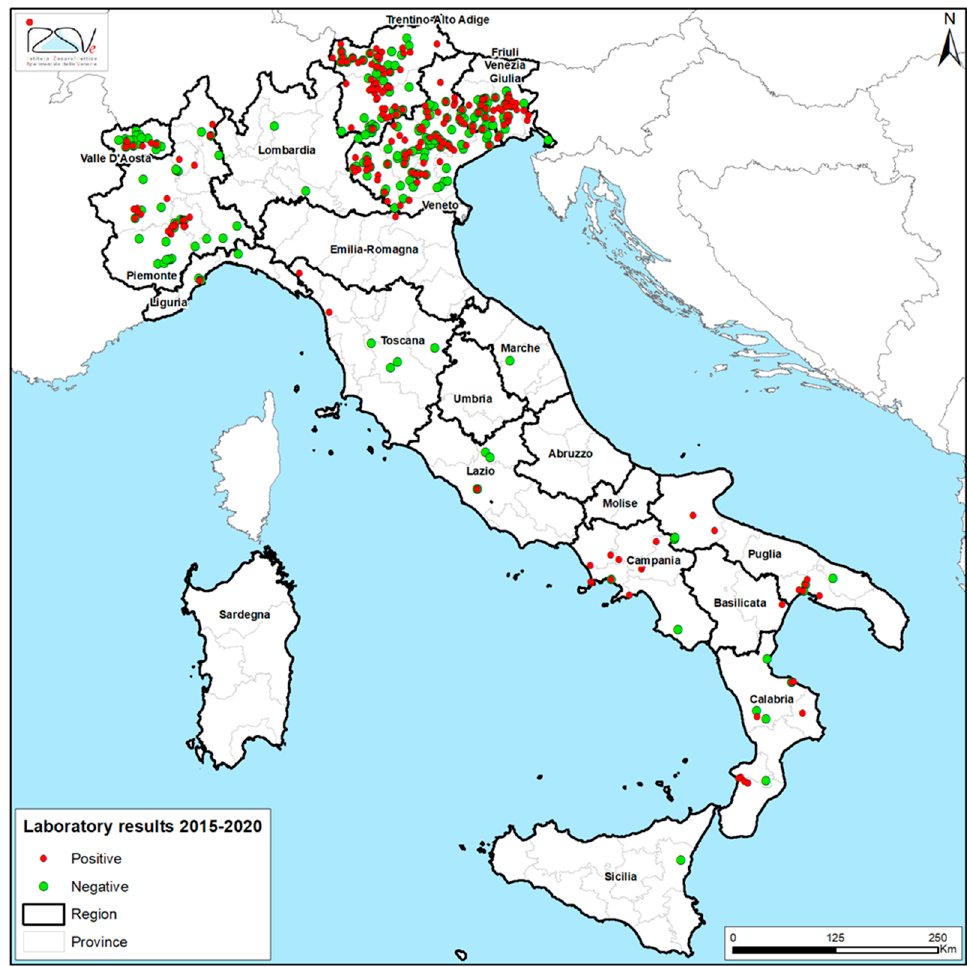
Figure 1. Cumulative location of the sampling points in Italy for all matrices related to reported mortality events from 2015 to 2020.